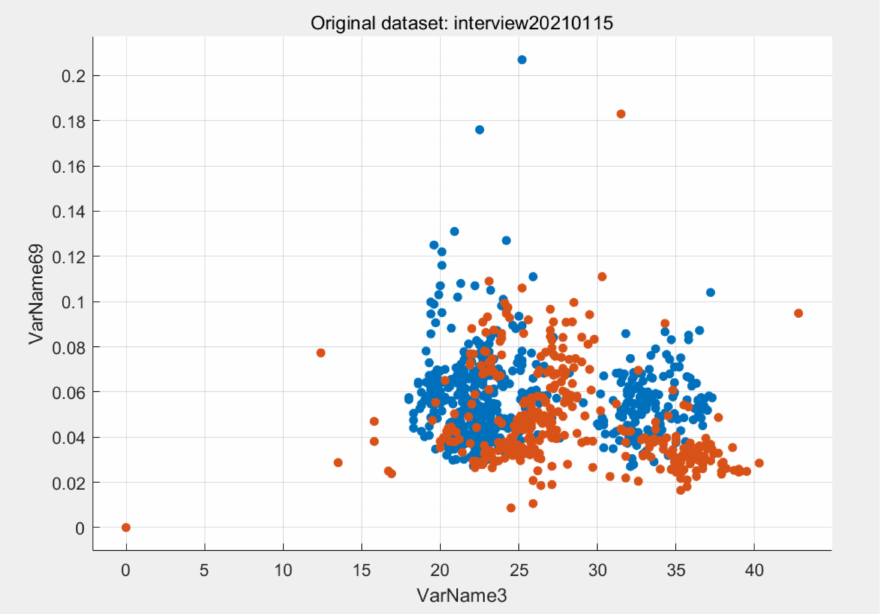
Figure 3. Scatter diagram of V3 and V69 in the interview database. The blue dot means there is no depression. The orange dots represents depression.